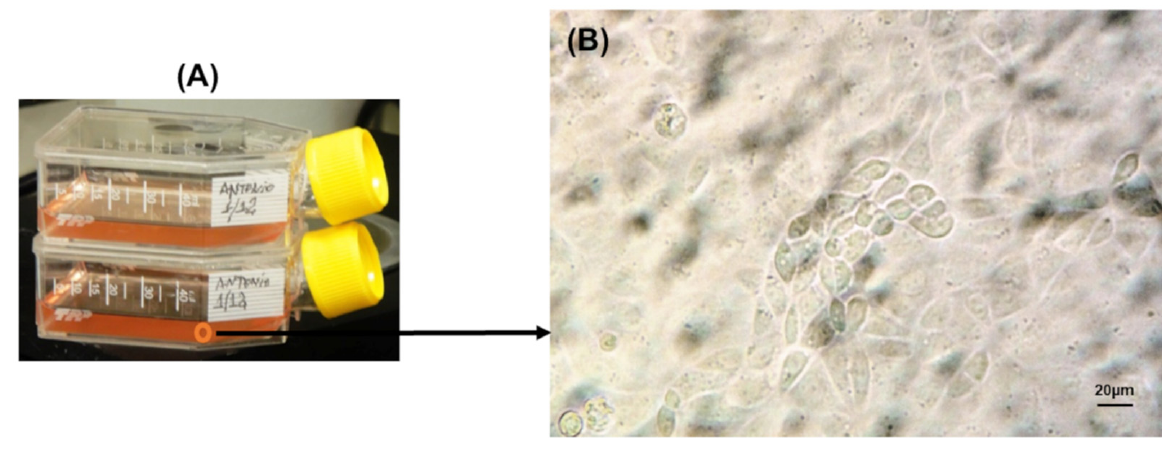
Figure 5. ( A ) Glass culture bottles with ZFL cells; ( B ) microscopic image of ZFL cells.